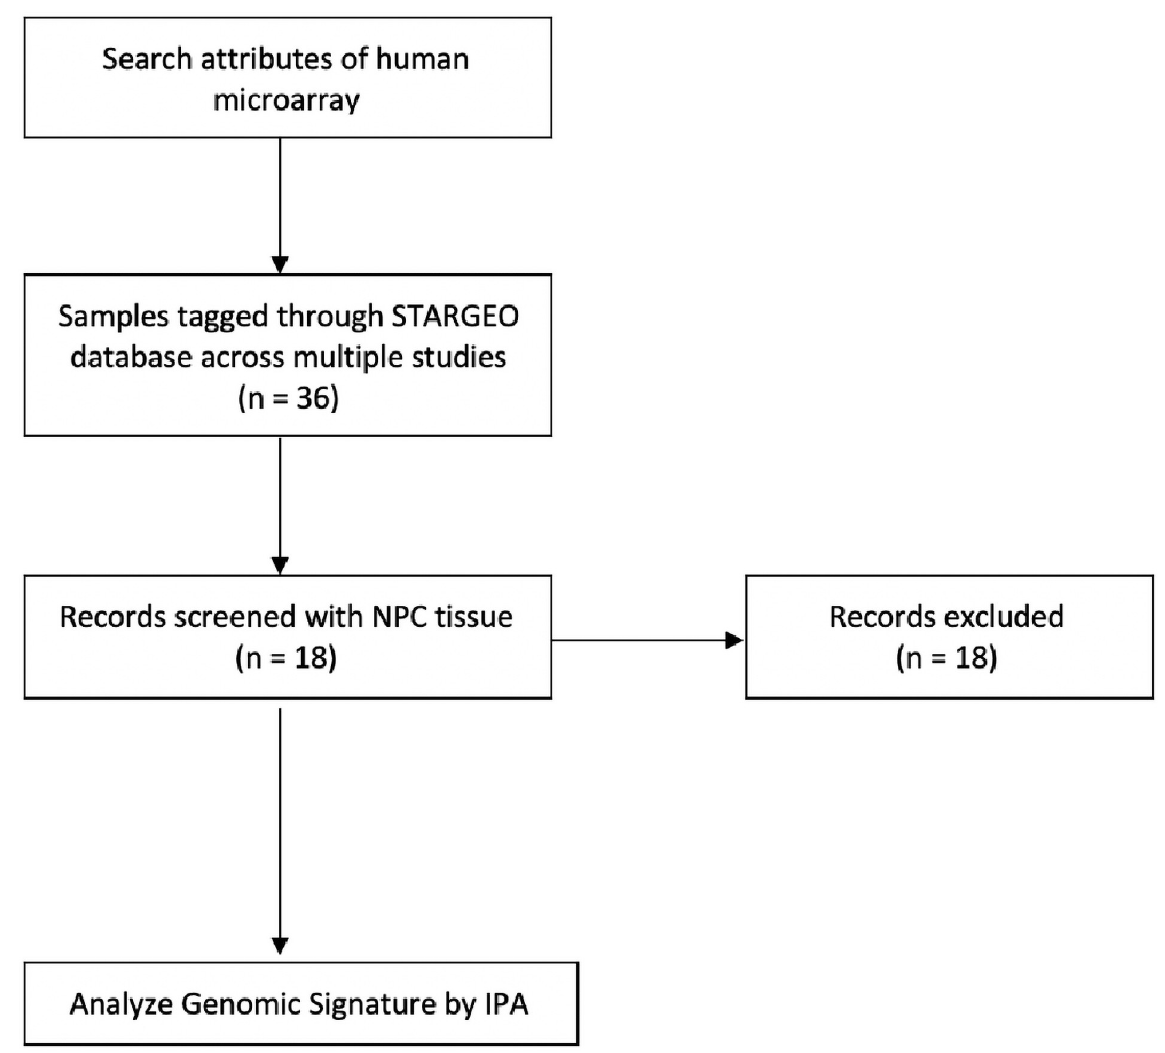
Fig 1. Modified PRISMA diagram of STARGEO sample